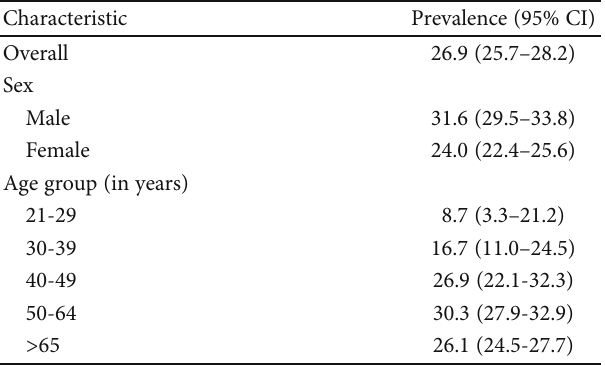
Table 3: Prevalence of H. pylori infections among subjects with GIM according to sex and age during 2012-2014 ( n = 4,701